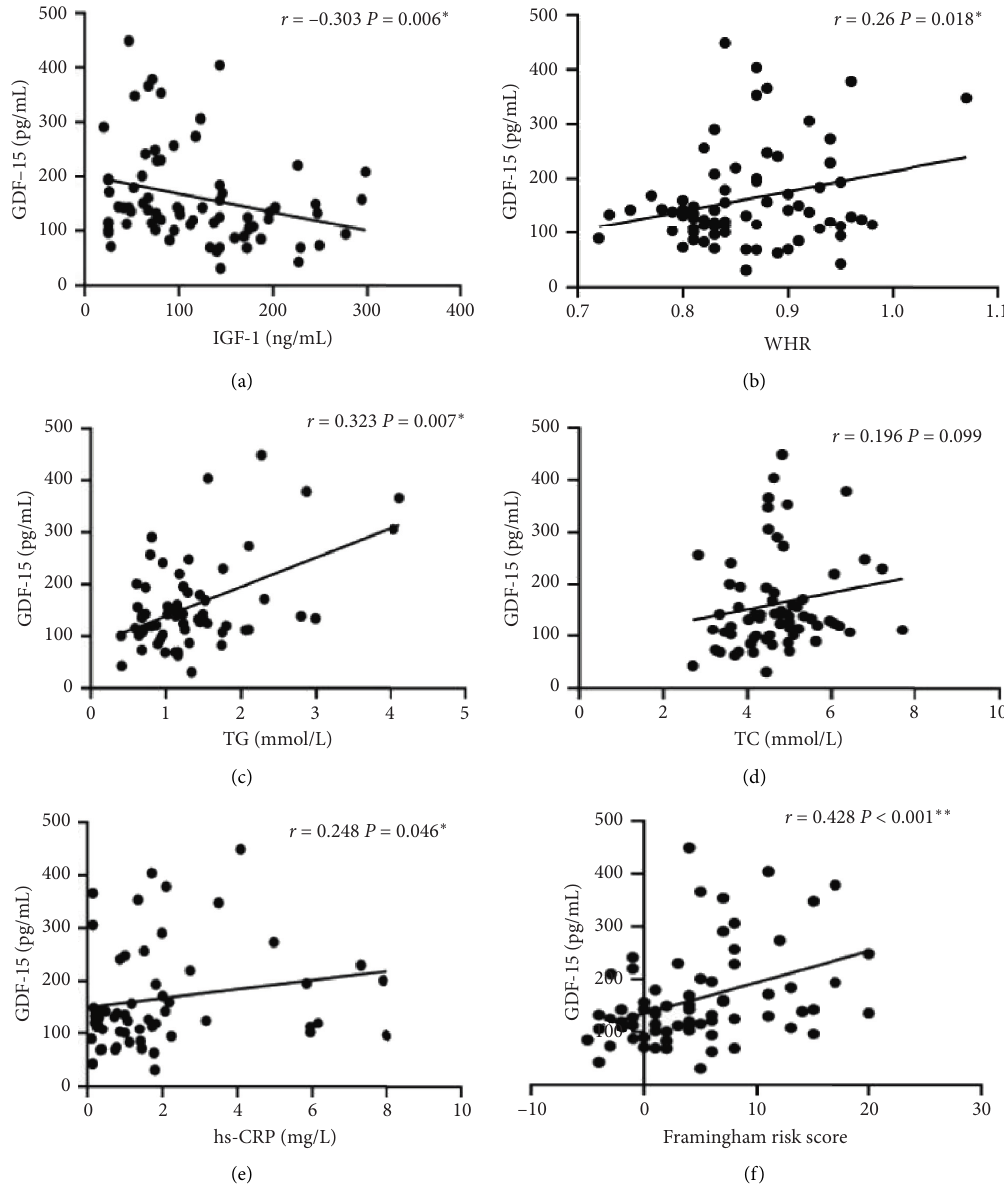
Figure 2: Correlations between GDF-15 and other indicators. GDF-15 was negatively correlated with (a) IGF-1 ( r � − 0.303, P � 0 . 006). GDF-15 was positively correlated with (b) WHR ( r � 0.26, P � 0 . 018), (c) TG ( r � 0.323, P � 0 . 007), (d) TC ( r � 0.196, P � 0 . 099), (e) hs-CRP ( r � 0.248, P � 0 . 046), and (f) FRS ( r � 0.428, P < 0 . 001) ( ∗ P < 0 . 05; ∗∗ P < 0 .